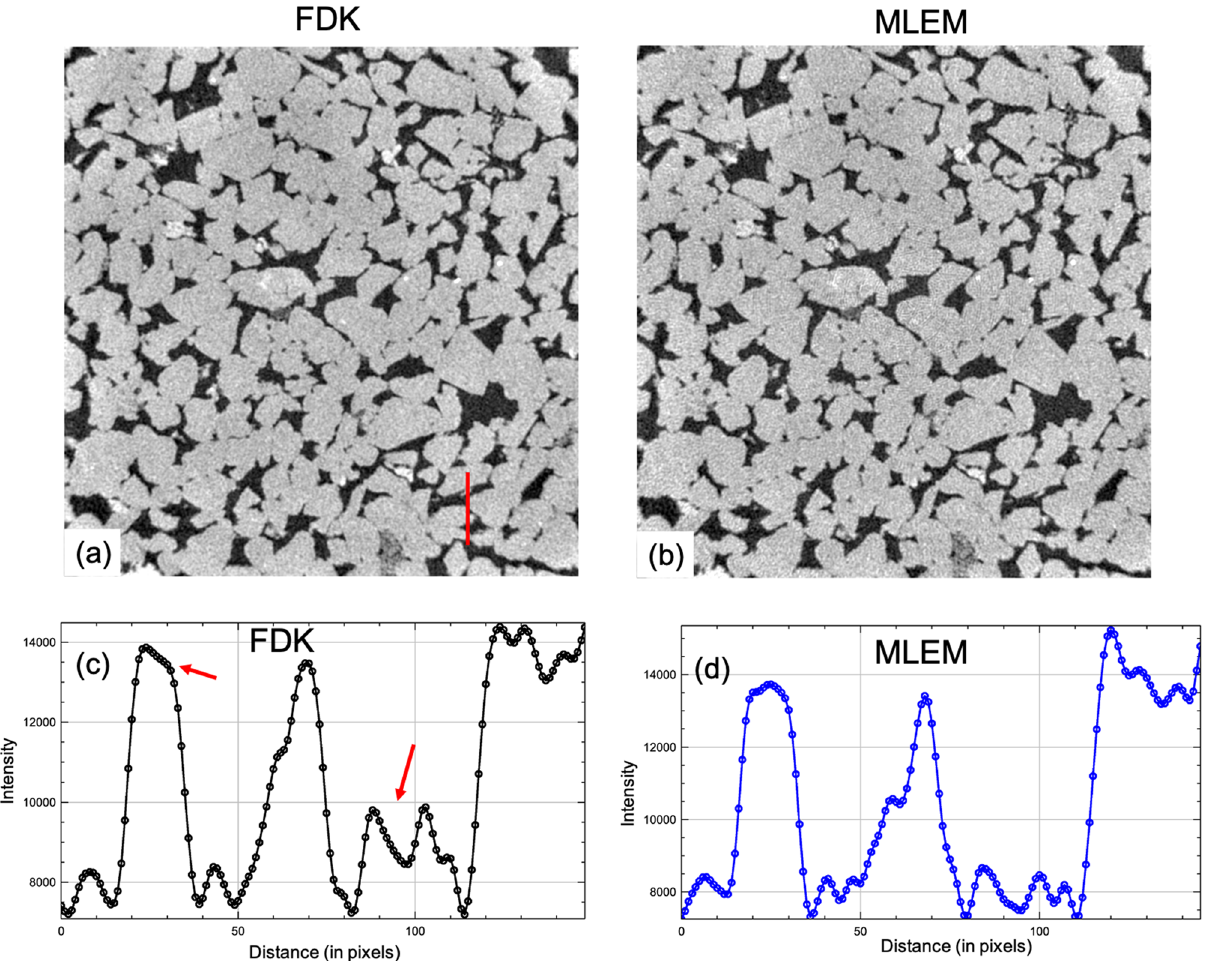
Figure 5. Comparison of FDK and MLEM reconstruction. ( a ) Reconstructed image obtained using FDK algorithm. ( b ) Reconstructed image obtained using multi-GPU MLEM based algorithm. ( c ) Line profile along the red line indicated in ( a ) using the FDK algorithm. ( d ) Line profile along the red line indicated in ( a ) using the MLEM